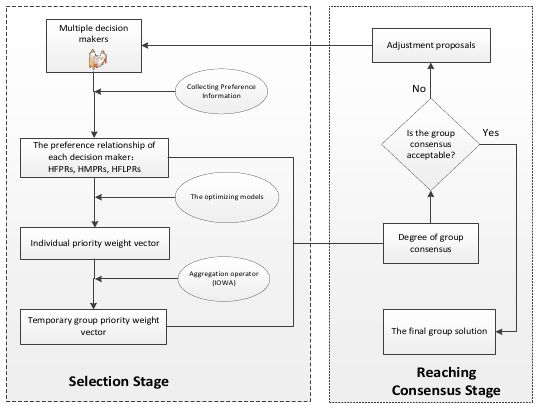
Figure 1. The framework of GDM with HHPRs.